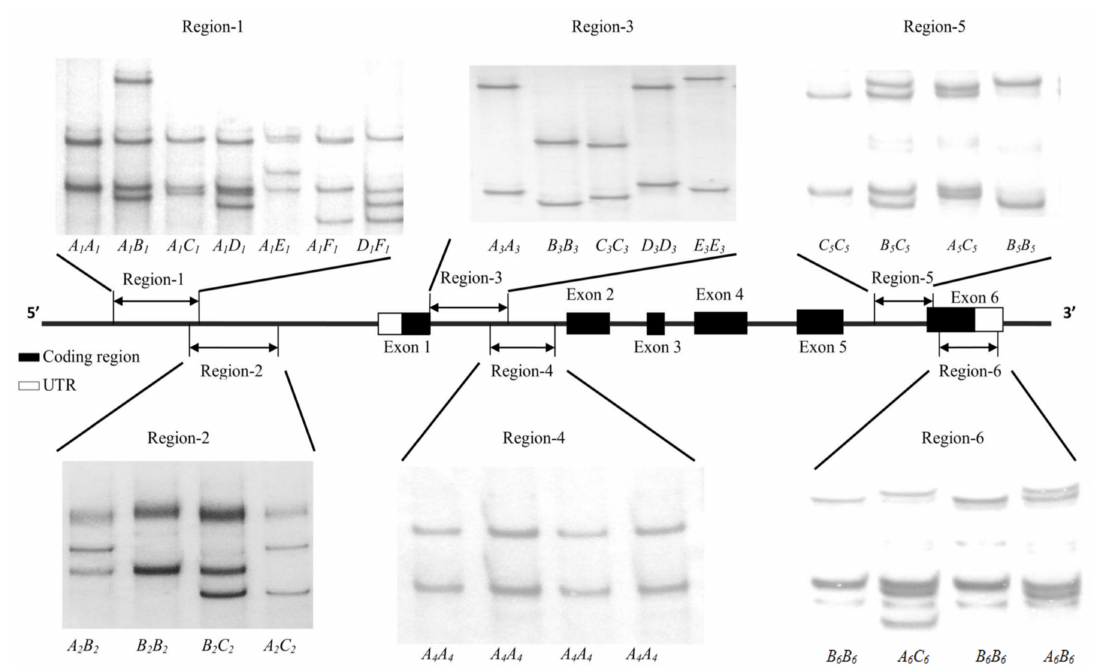
Figure 1. Polymerase chain reaction-single-stranded conformational polymorphism (PCR-SSCP) banding patterns of ovine uncoupling protein-1 gene ( UCP1 ). Unique PCR-SSCP patterns representing different DNA sequences were detected. Six unique patterns corresponding to six variants